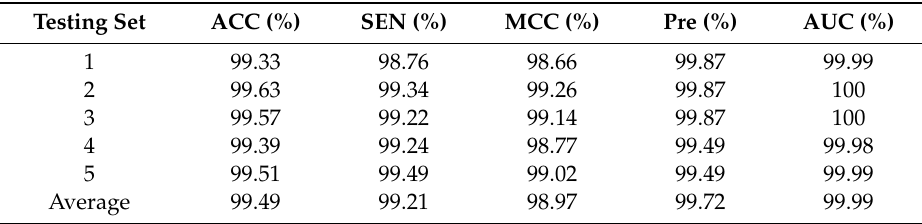
Table 1. five-fold cross-validation results on the human data set.